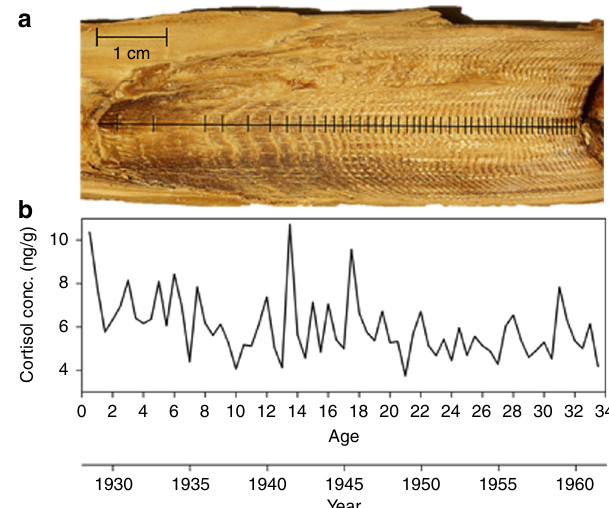
Fig. 1 Whale earplug cortisol pro fi le with age and year timeline. a Image of a bisected whale earplug with individual laminae identi fi ed with black vertical lines. b Graph illustrates reconstructed lifetime cortisol pro fi le (ng/g) as a function of age and